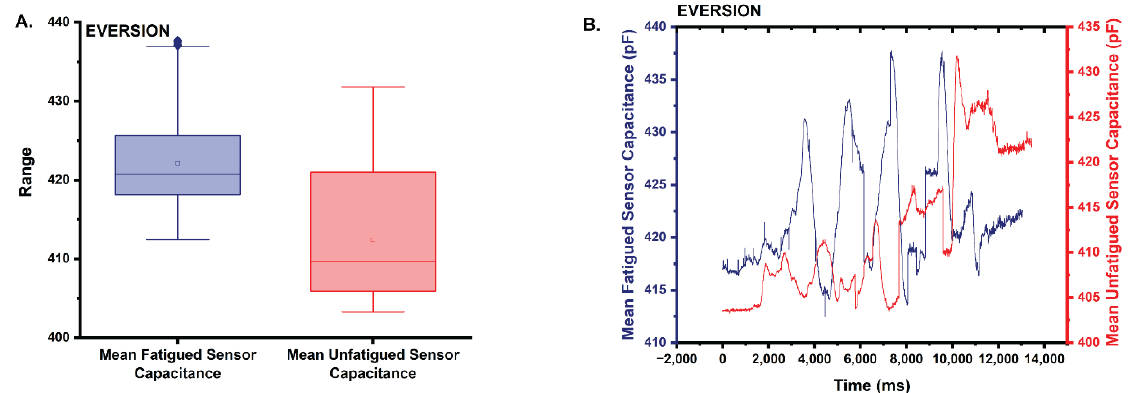
Figure 10. ( A ) Box plot of the statistics comparing the mean capacitance of the fatigued sensor to that of the unfatigued sensor in eversion. Note that the mean capacitance is higher for the fatigued sensor. ( B ) Plot comparing the mean capacitance of the fatigued sensor to the unfatigued sensor during the eversion trials.